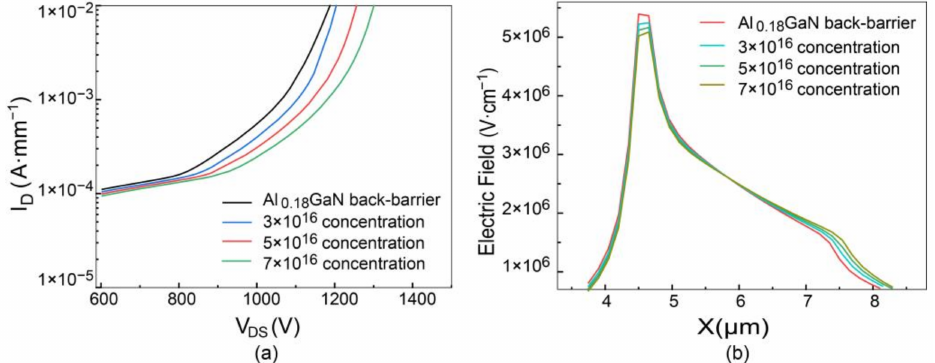
Figure 2. ( a ) The BV characteristics (@V gate = − 10 V, V source = 0 V) and ( b ) the electric field distribution of the compared